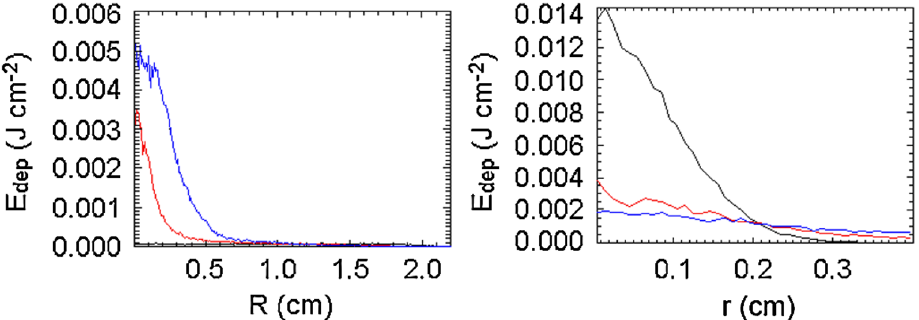
(cid:9) r (cid:10) profiles for the (cid:2) 222 ns of prepulse before t (cid:6) 1319 ns (red), 3 ns of main pulse from t (cid:6) FIG. 23. (Color) Cumulative E dep 1319 – 1322 ns (black), and (cid:2) 475 ns of postpulse after t (cid:6) 1322 ns (blue) at the focal plane for the (cid:2) (cid:3) (cid:1) 32 : 3 mrad (right) cases. Note the difference in scales, and the main pulse E 10 (cid:1) 5 J cm (cid:1) 2 to r (cid:6) 2 cm